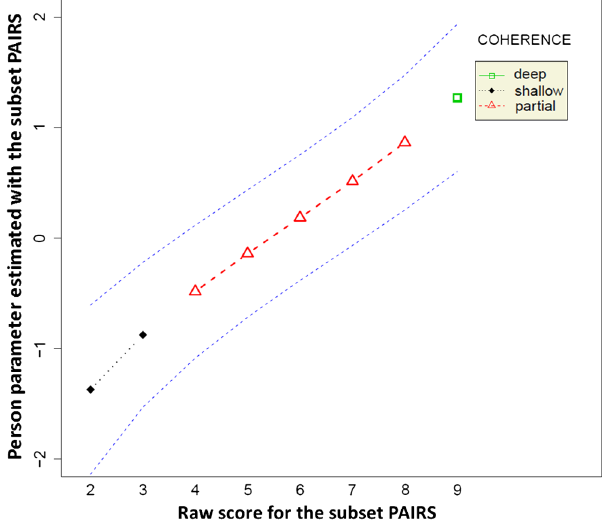
FIG. 8. Assignment to a knowledge-coherence category. The person parameters estimated in the partial credit model are plotted against the raw scores for the item-subset PAIRS. The maximum possible score is 12. The dashed lines are at 1 standard error distance from the point estimate. The assignment to one of the three knowledge-coherence categories listed in the legend de- pends on the person ’ s location on the scale PAIRS.